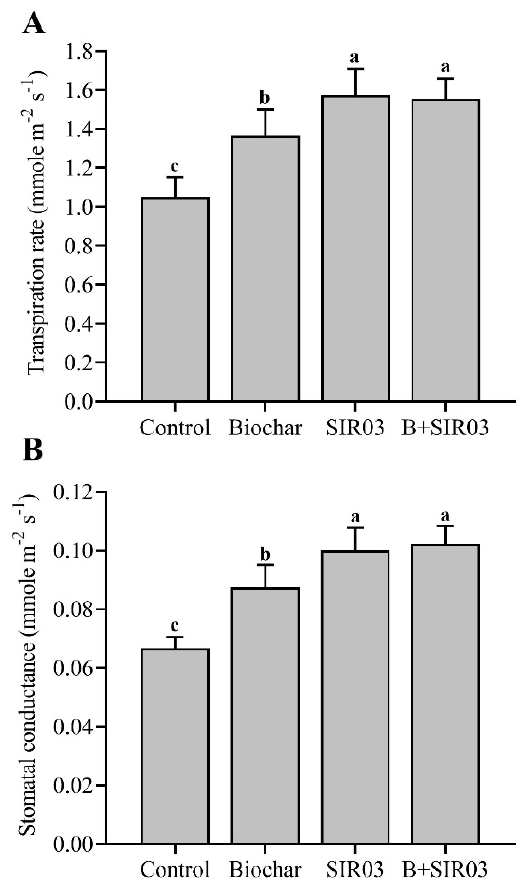
Figure 4. Effects of isolate SIR03 on ( A ) transpiration rate and ( B ) stomatal conductance in sesame seedlings. Control represents (non-inoculated); Biochar represents biochar treated; SIR03 is the bacterial isolate; B + SIR03 represents the combined application of biochar and SIR03 strain. The values are means ± standard deviations of three replicates. Values indexed with different letters represent significant differences between treatments, evaluated by Duncan’s multiple range test at p ˂ 0.05.